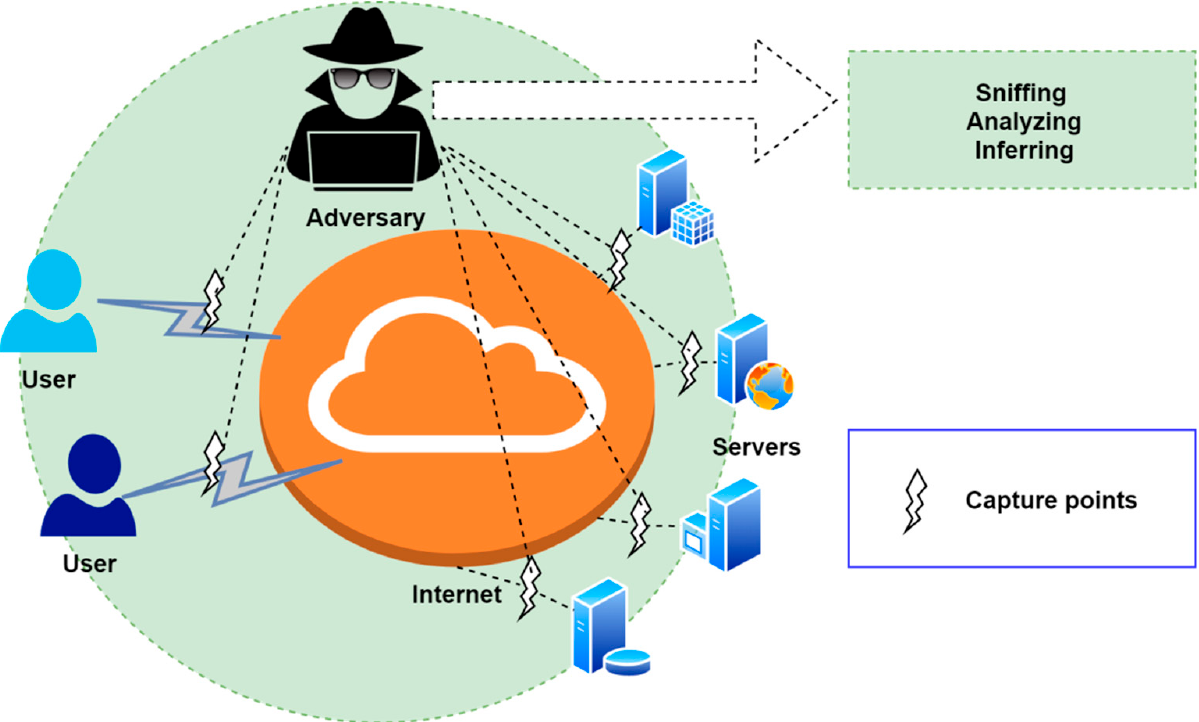
Figure 2. Security threats.